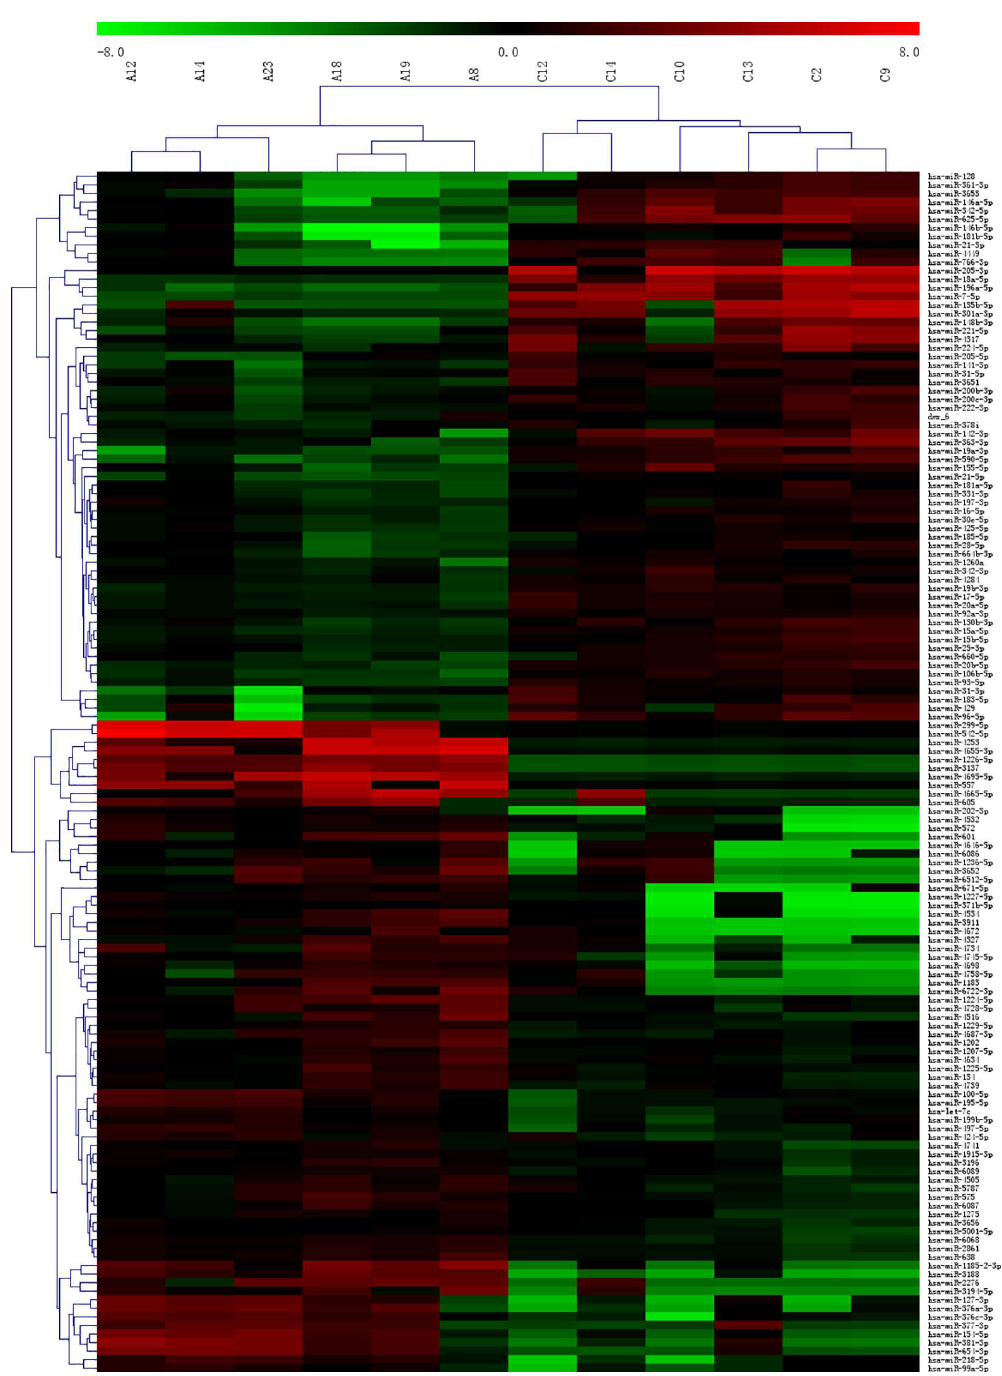
Fig 2. Cluster analysis of miRNA microarrays for cervical cancer and normal